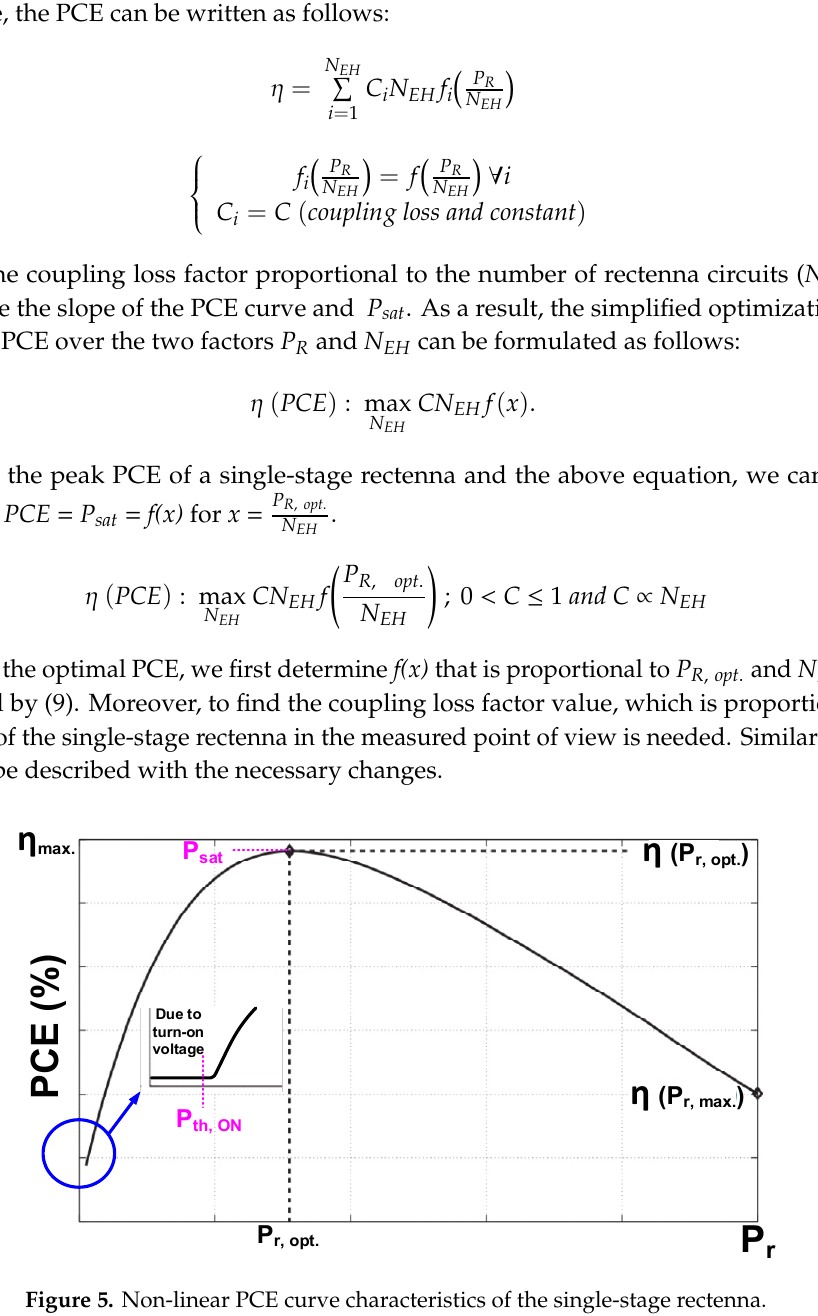
Figure 5. Non-linear PCE curve characteristics of the single-stage rectenna.